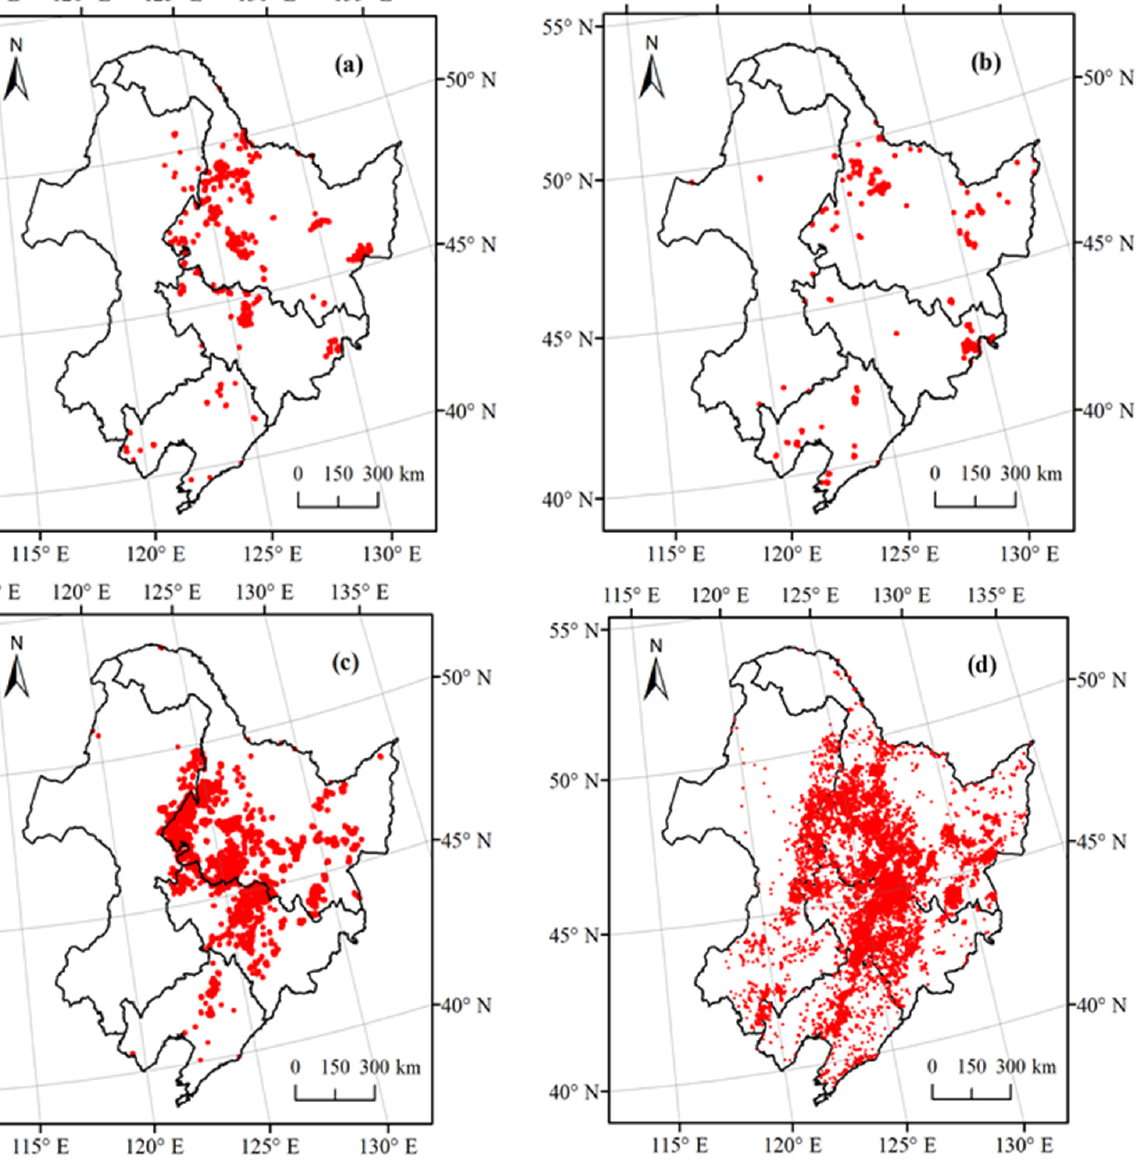
Figure 2. Fire points for open crop burning observed by Himawari-8 between 16 March and 20 April each year in 2018 ( a ), 2019 ( b ), 2020 ( c ) and 2021 ( d ).